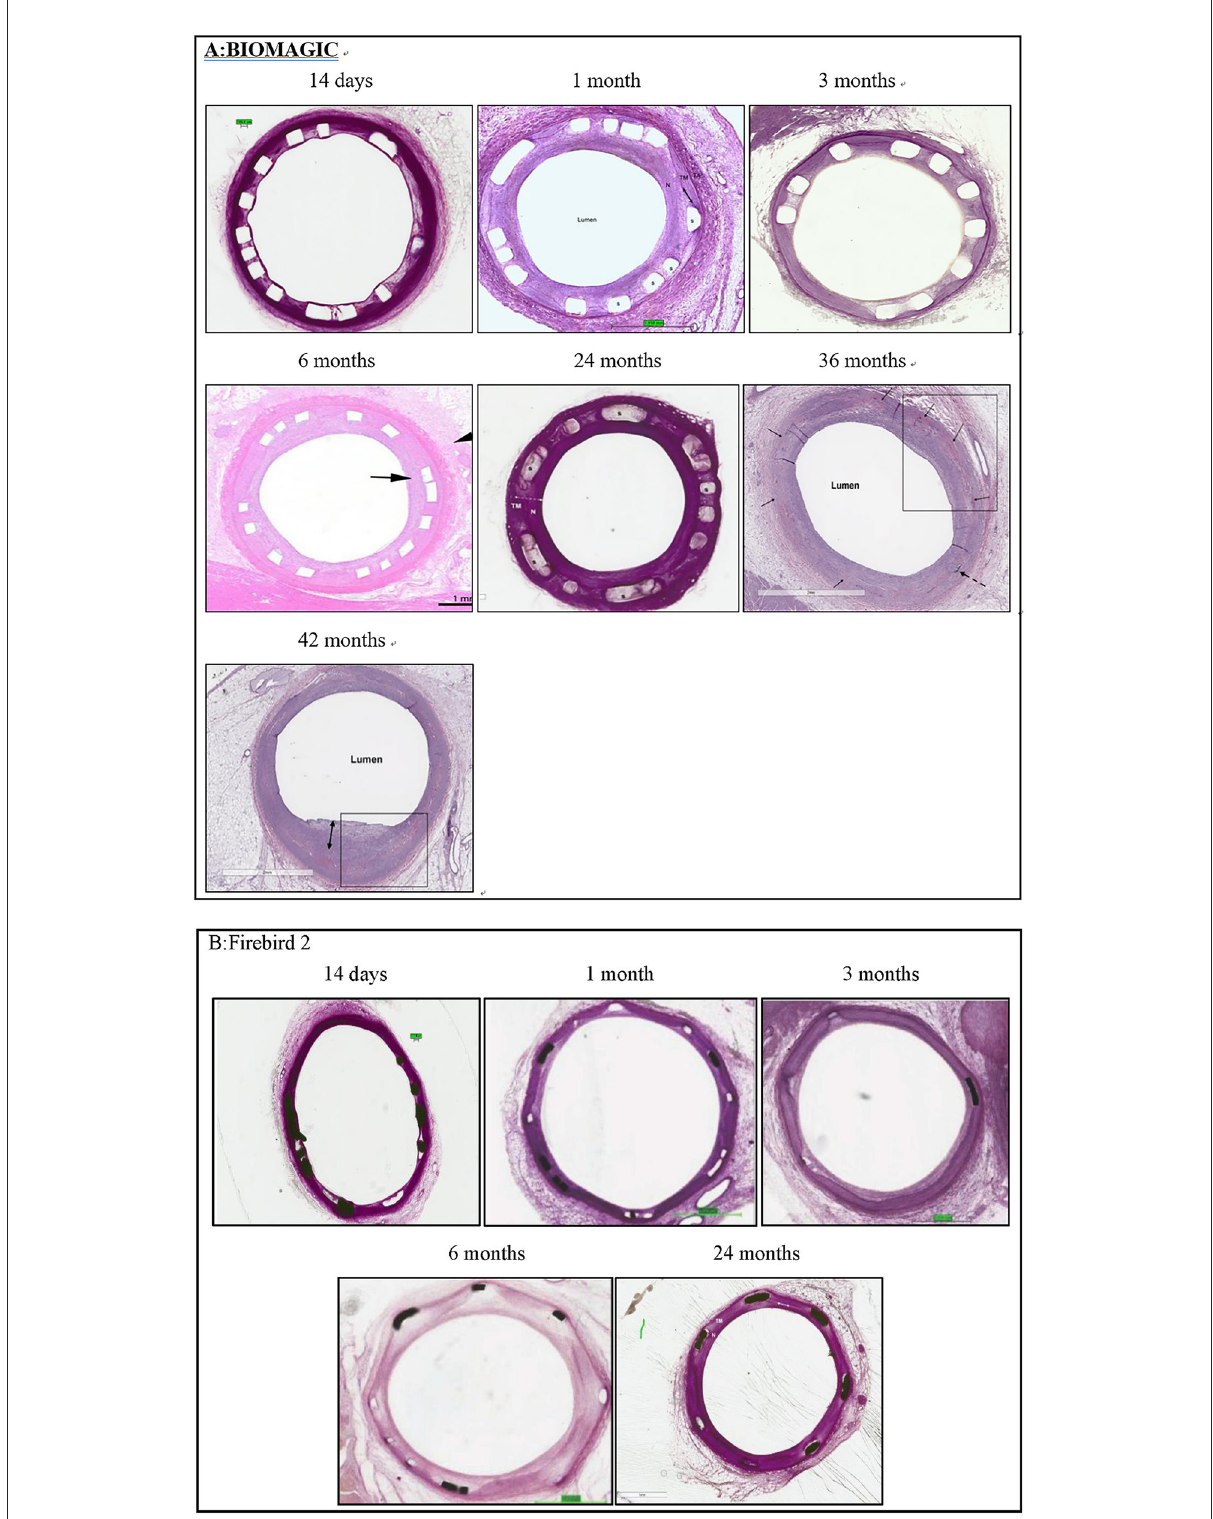
FIGURE2 Representative histological images histomorphological analysis was performed by conventional paraffin histological technique and hematoxylin eosin stain. (A) Typical histological images of Biomagic BVS in porcine coronary artery from 14 days to 42 months. (B) Typical histological images of Firebird2 DES in porcine coronary artery from 14 days to 42 months. Firebird2 was not observed by OCT for 36 and 42